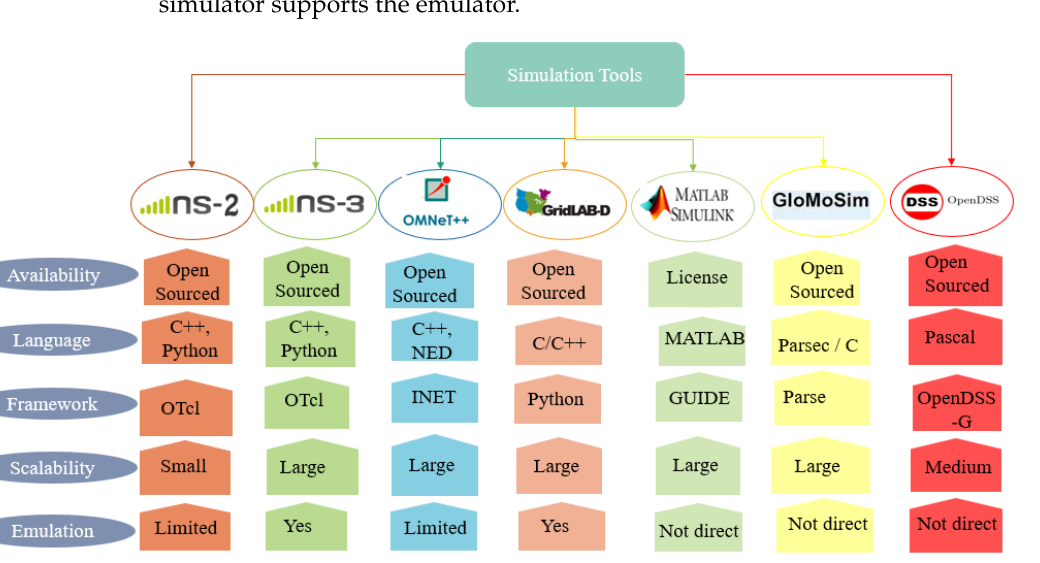
Figure 16. Simulation